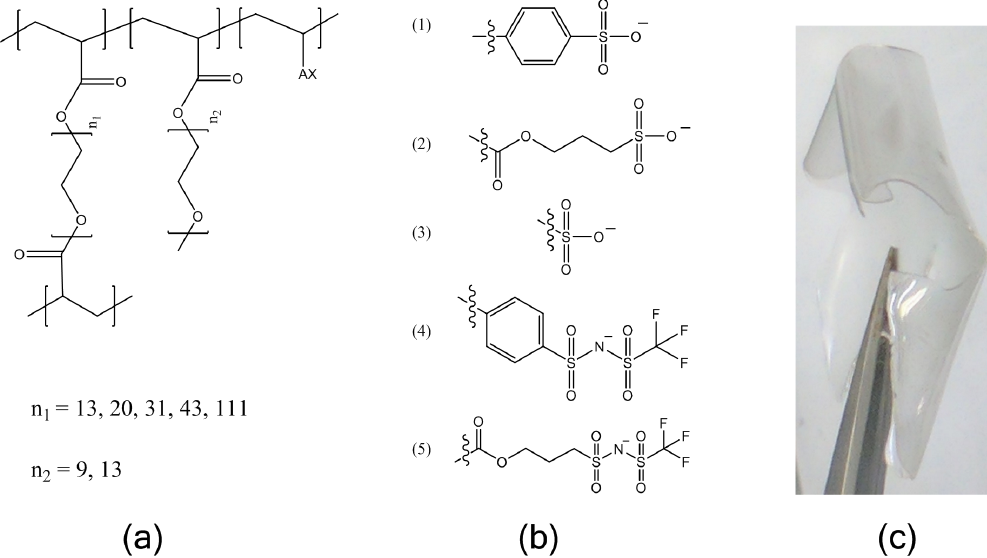
Figure 1. Chemical structures of ( a ) crosslinked ionomeric electrolytes, where A is the tethered anion and X is the counter ‐ cation, and ( b ) the tethered anions, referred to as follows: (1) SS, (2) APS, (3) VS, (4) STFSI, and (5) APTFSI. A photograph of a typical crosslinked electrolyte is shown in ( c ).